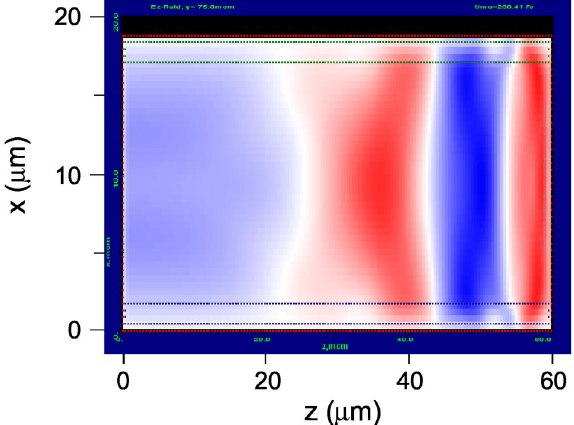
FIG. 3. (Color) Wakefield in the x - y plane at z (cid:3) 51 (cid:4) m . The moving bunch is located at z (cid:3) 60 (cid:4) m . The vertical and horizontal scales are not the same: 150 (cid:4) m tall by 18 : 8 (cid:4) m wide. Note the field is nearly uniform except for around the two y ends. The dielectric boundaries are shown as vertical lines on the left and the right.